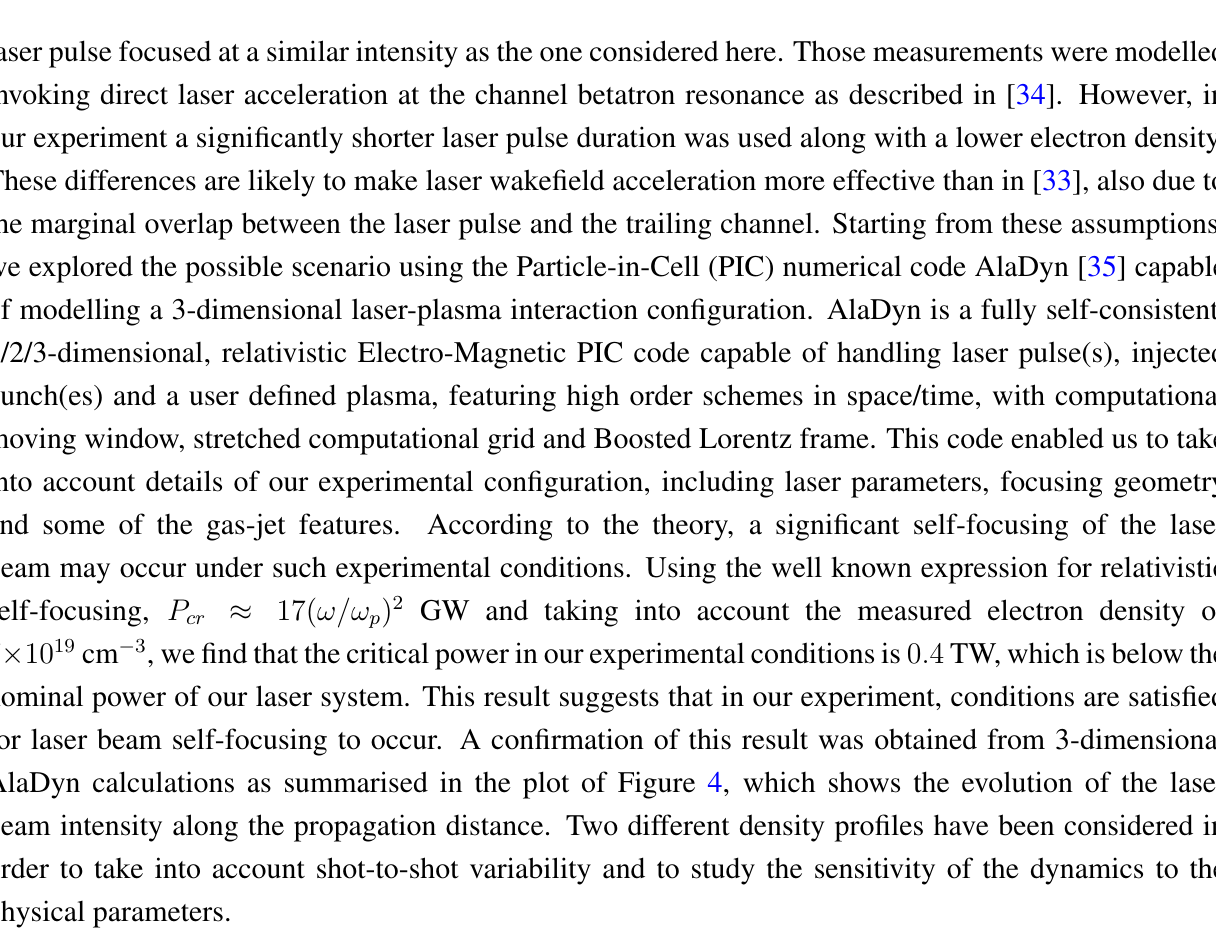
Figure 4. Evolution of the beam intensity (in red) as obtained by Aladyn PIC simulations (see text), showing that in our experimental conditions a strong self-focusing occurs on a longitudinal scale length of less than 100 µ m, leading to a more than 10-fold increase of the local intensity. The solid and dashed lines refer respectively to the density profiles #1 and